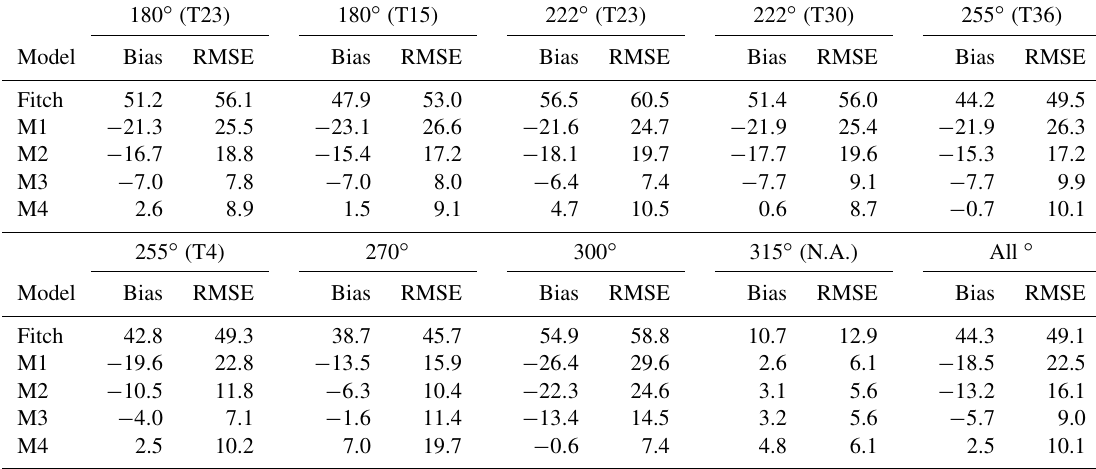
Table 1. Bias and root-mean-square error (RMSE) in power prediction by the Fitch parameterization and by the Jensen parameterization with the wake overlap methods, M1, M2, M3, and M4, at Lillgrund for single-cell cases (in percent). The wind turbine columns are shown in Fig. 4a–h, and the leading turbine of each column is indicated in parentheses where there is ambiguity. “N.A.” in parentheses represents the non-alignment wind direction. The results are from